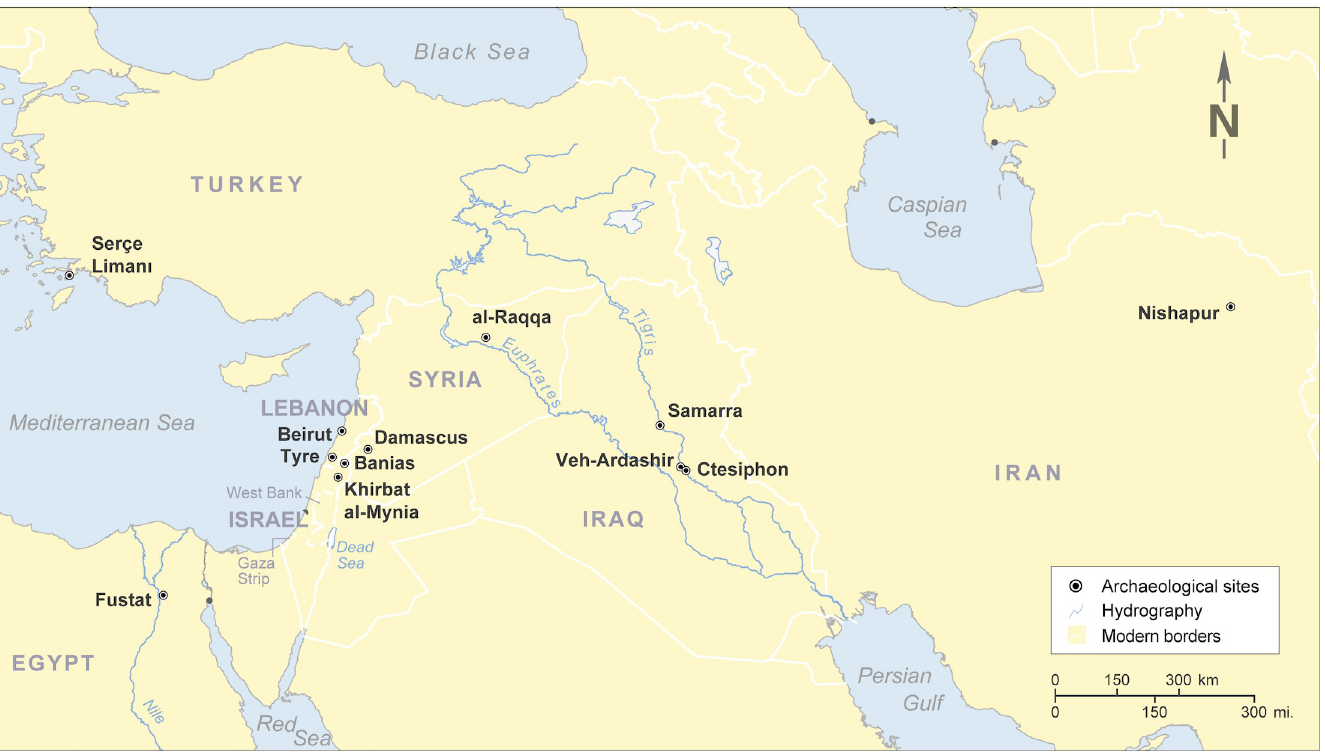
Fig 10. Location of the archaeological sites where the plant-ash glasses used as reference were found (map: Courtesy of CIA’s The World Factbook 2020, modified).